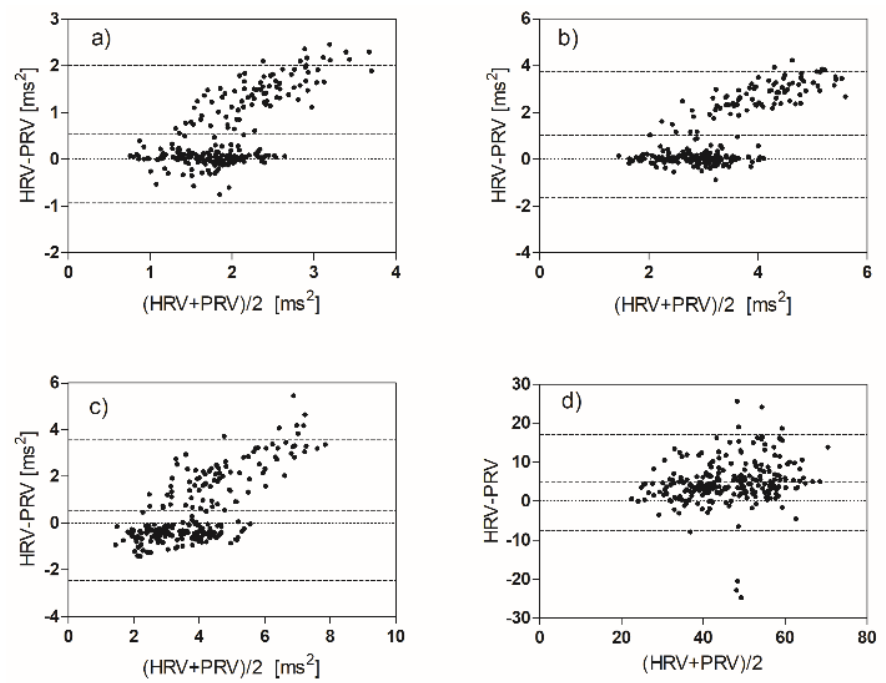
Figure 9. Bland − Altman plots comparing HRV and PRV measurements: ( a ) VLF, ( b ) LF, ( c ) HF, ( d ) pLF.